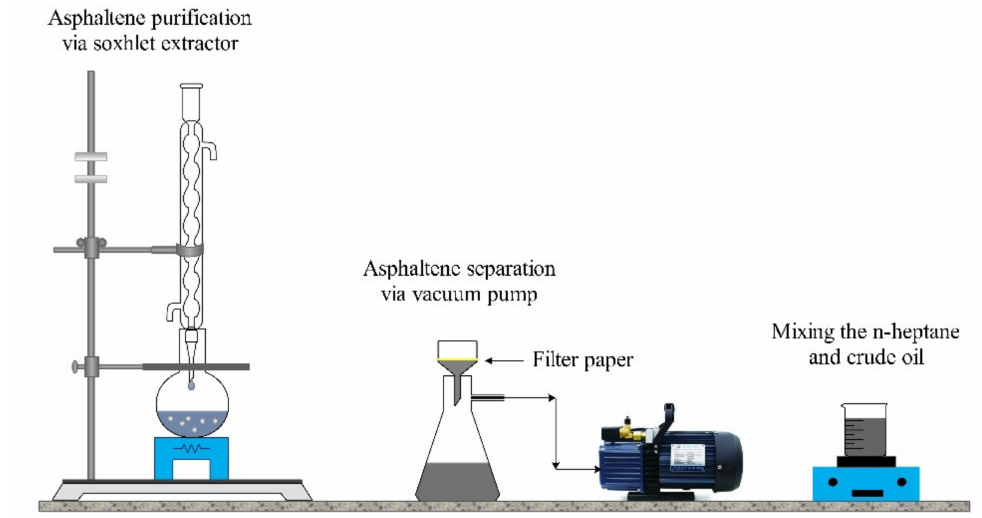
Figure 4. Schematic of the asphaltene extraction